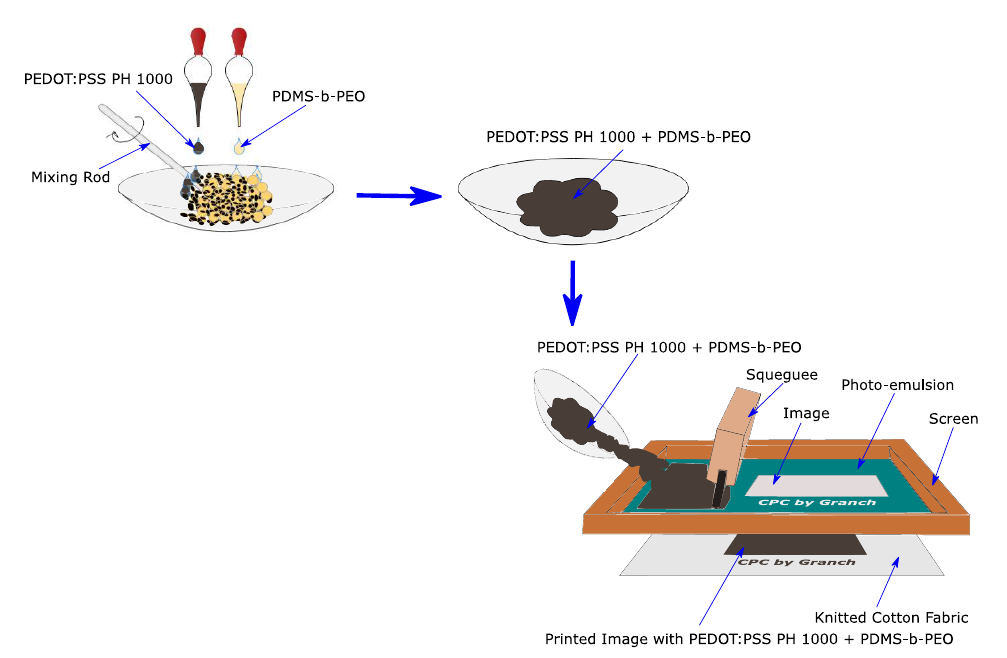
Figure 3. Screen printing of conductive polymer composite on knitted cotton fabric.